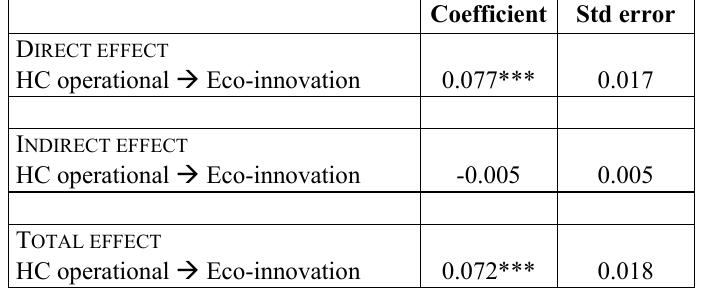
Table 3: Direct, Indirect, and Total Effects of HC Operational on Eco-innovation